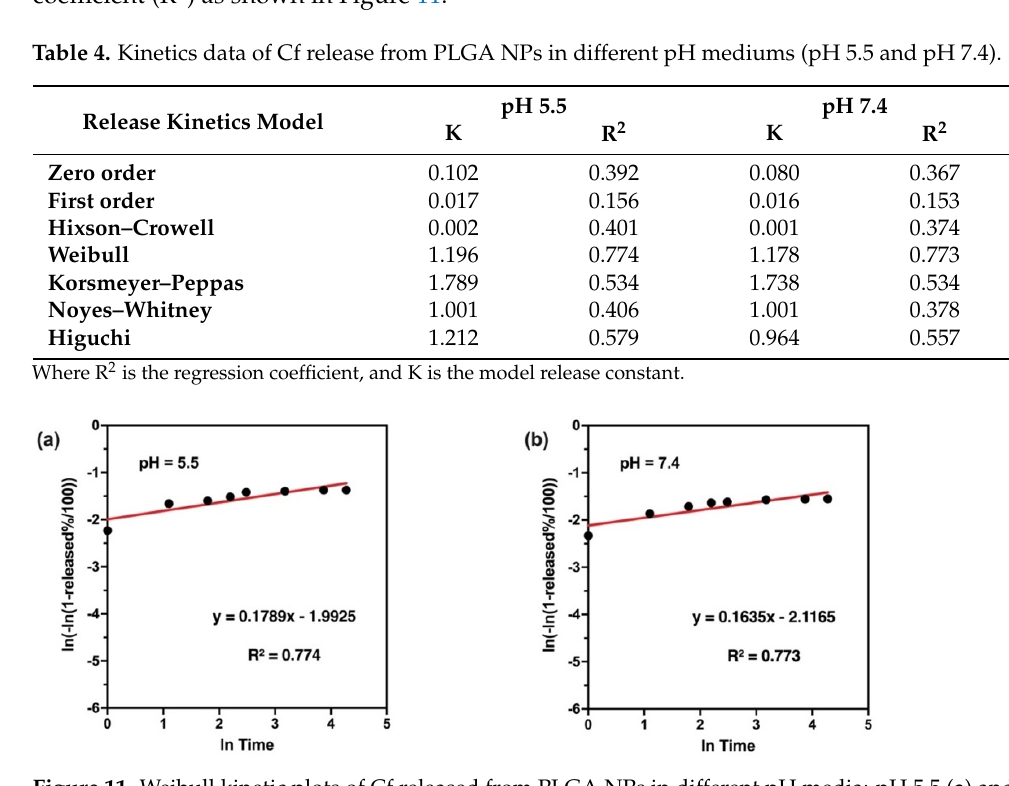
Figure 11. Weibull kinetic plots of Cf released from PLGA NPs in different pH media: pH 5.5 ( a ) and pH 7.4 ( b ).